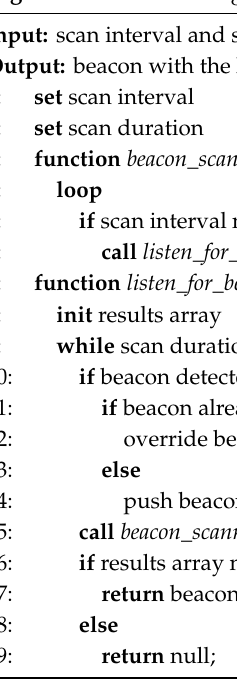
Algorithm 1 The basic